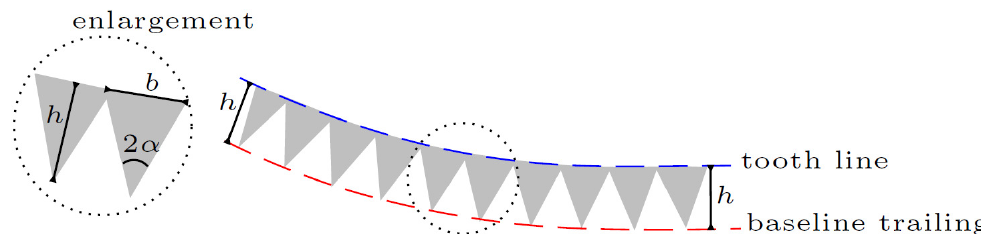
Figure 5. Sketch of the serrated trailing edge. In the enlargement of figure, the main geometrical parameters of the tooth are reported: tooth basis b , height h and the serration angle α